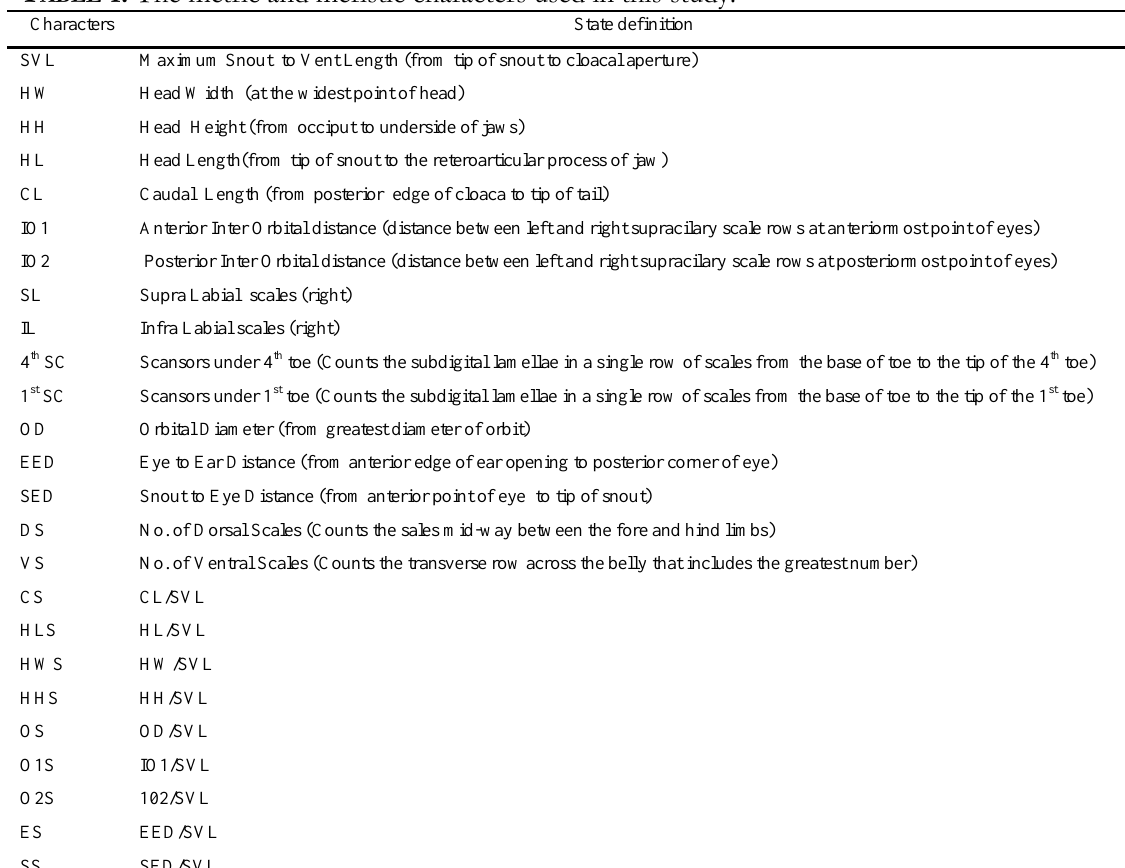
F IGURE 1. Map of the study area for the collected samples ( Hemidactylus). T ABLE 1. The metric and meristic characters used in this